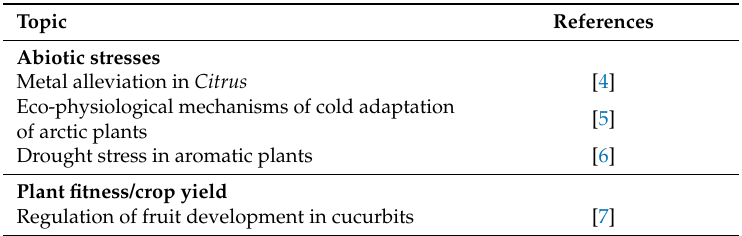
Table 1. Contribution of metabolomics to basic and applied plant